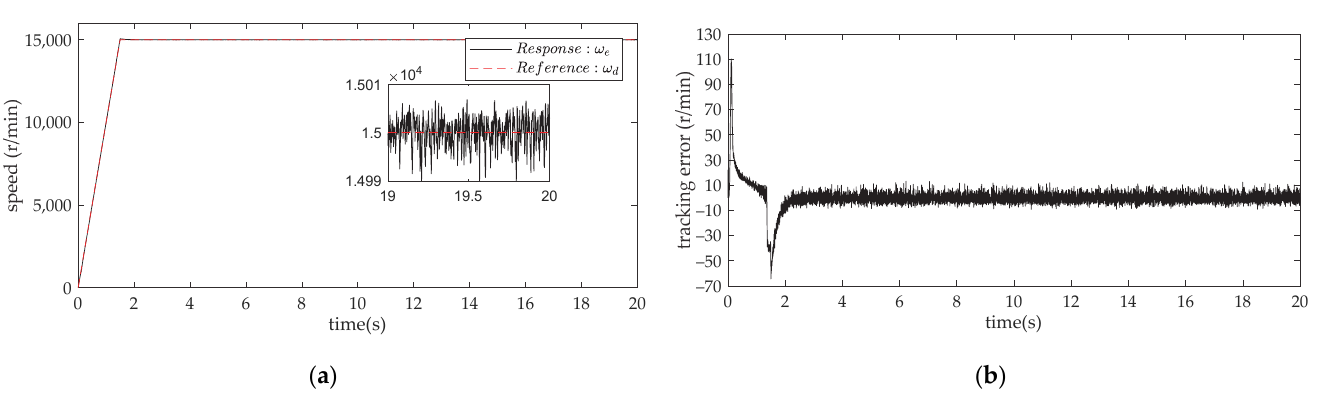
Figure 6. Torque response.